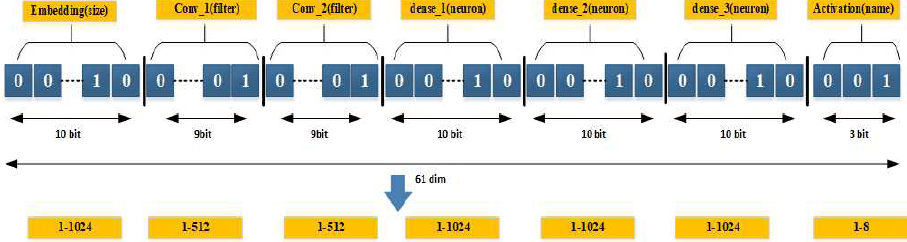
Figure 20. Determining CNNEM in-depth model parameters and problem dimensions for the proposed BAOVAH approach.